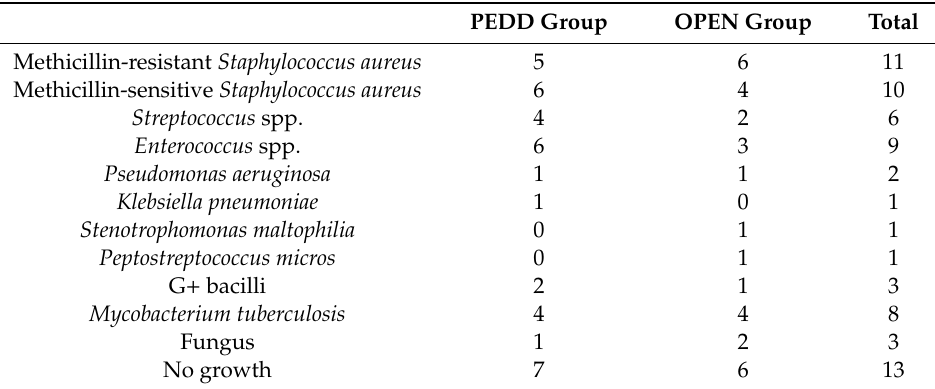
Table 3. Summary of causative